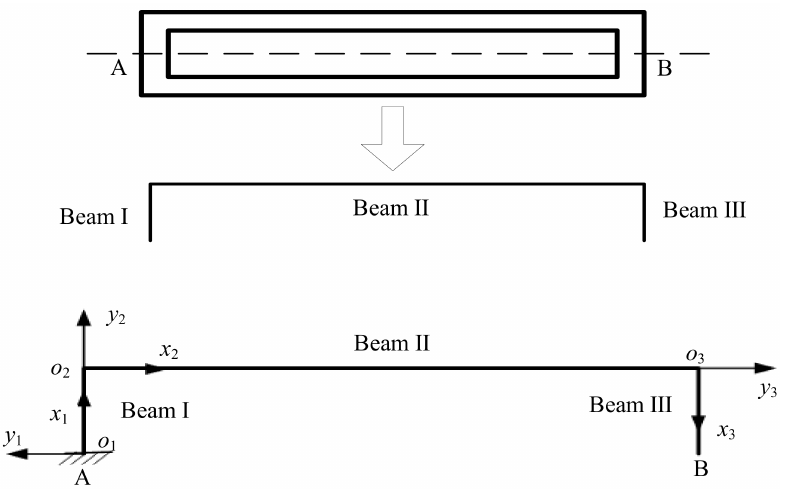
Figure 2. Simplified resonator